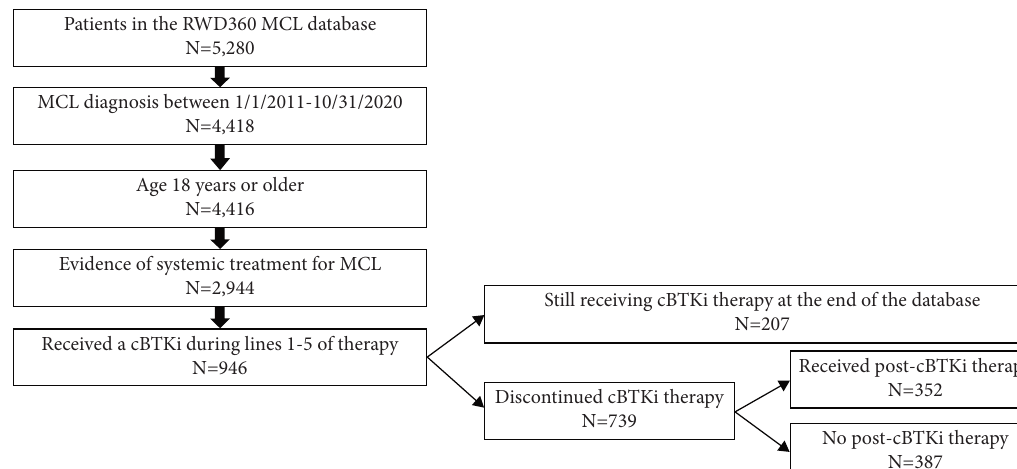
Figure 1: Flow chart of study cohort selection. Abbreviations: MCL � mantle cell lymphoma; cBTKi � covalent bruton tyrosine kinase